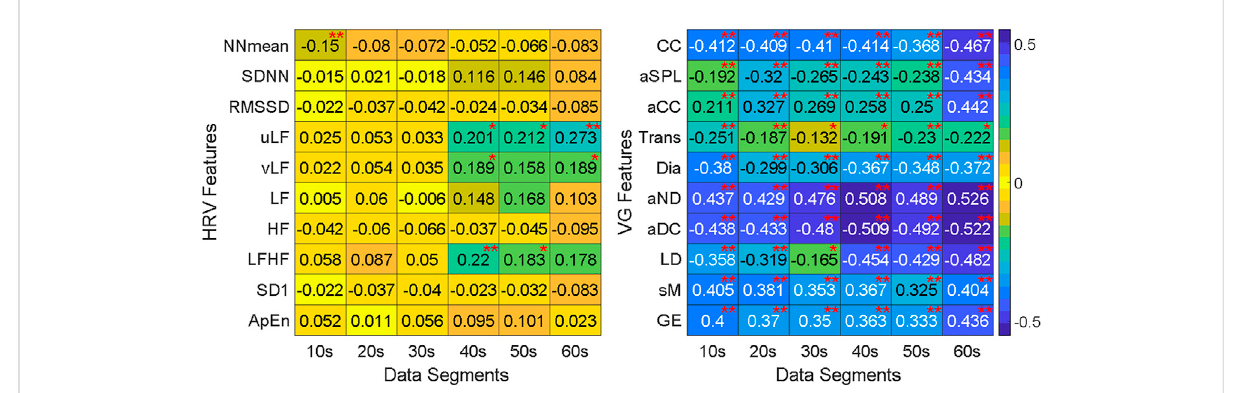
FIGURE 7 The Kendall rank correlation coef fi cients between features and segment length under different burst load. “ * ” stands for signi fi cant correlation between features and ANS-Load ( p < 0.05) and “ ** ” stands for extremely signi fi cant correlation ( p <